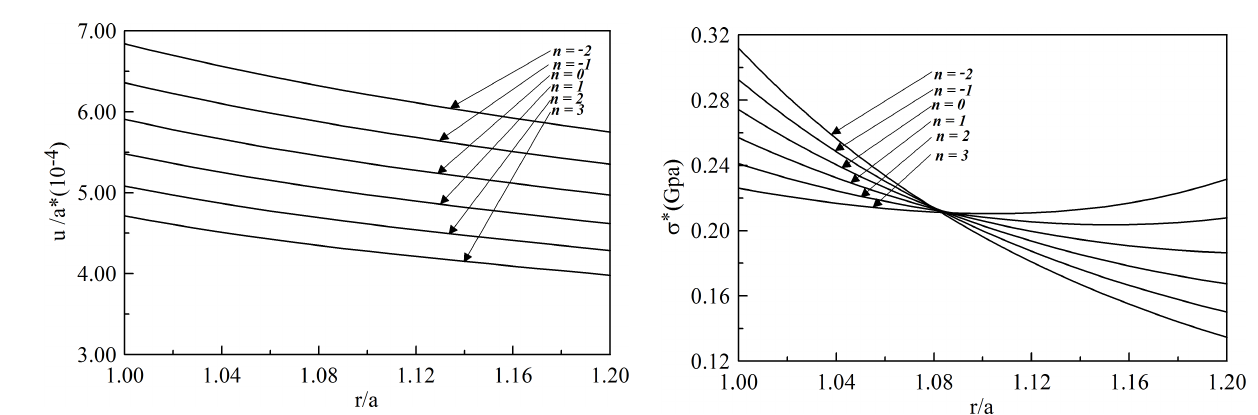
Figure 34: Radially distributed tangential stress